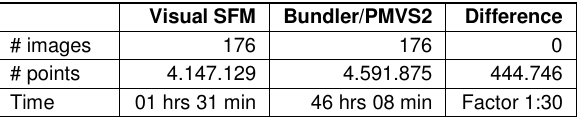
Table 1. Statistics on the point cloud generation of the four exterior walls using different software